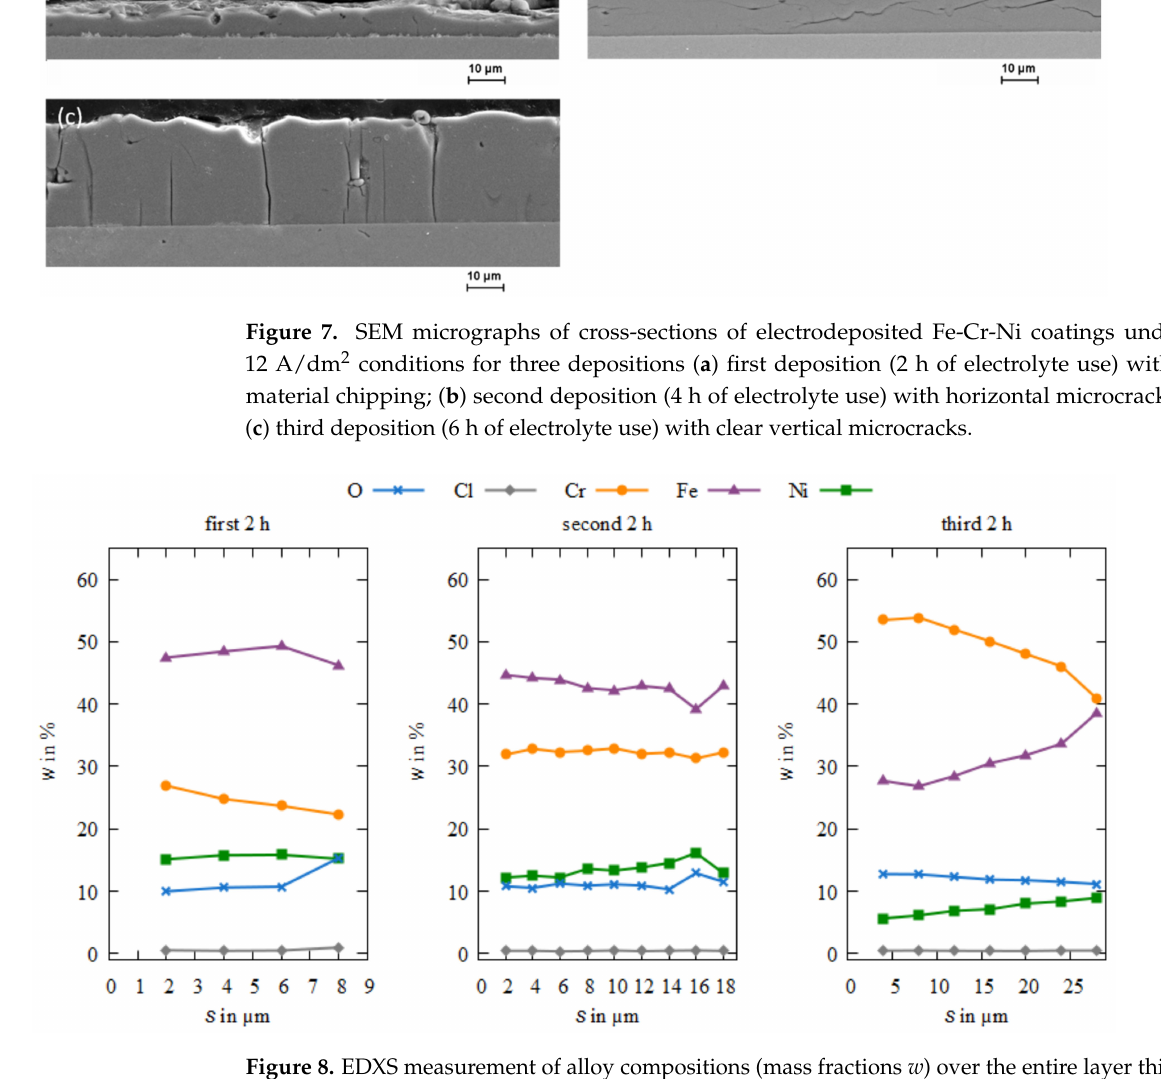
Figure 8. EDXS measurement of alloy compositions (mass fractions w ) over the entire layer thickness ( s —distance from the substrate) of the DC 12 A/dm 2 samples depending on the electrolyte